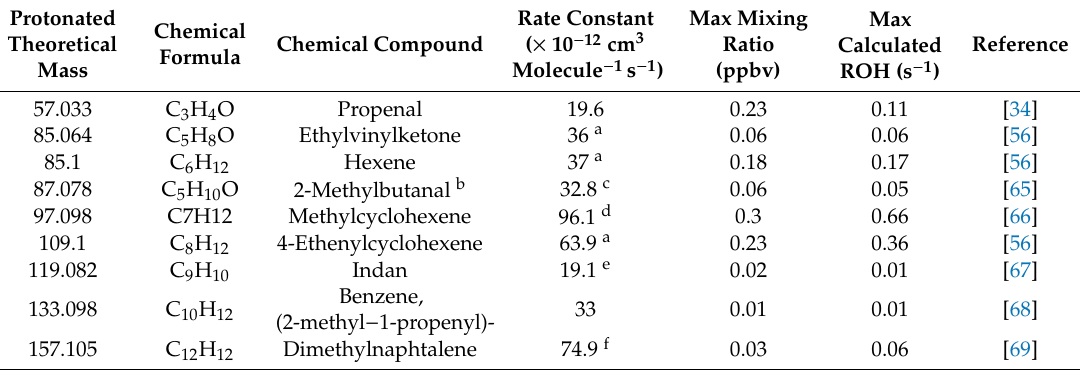
Table 4. List of the 9 selected masses which presented a correlation of 80% and more with isoprene ( m / z 69.070).